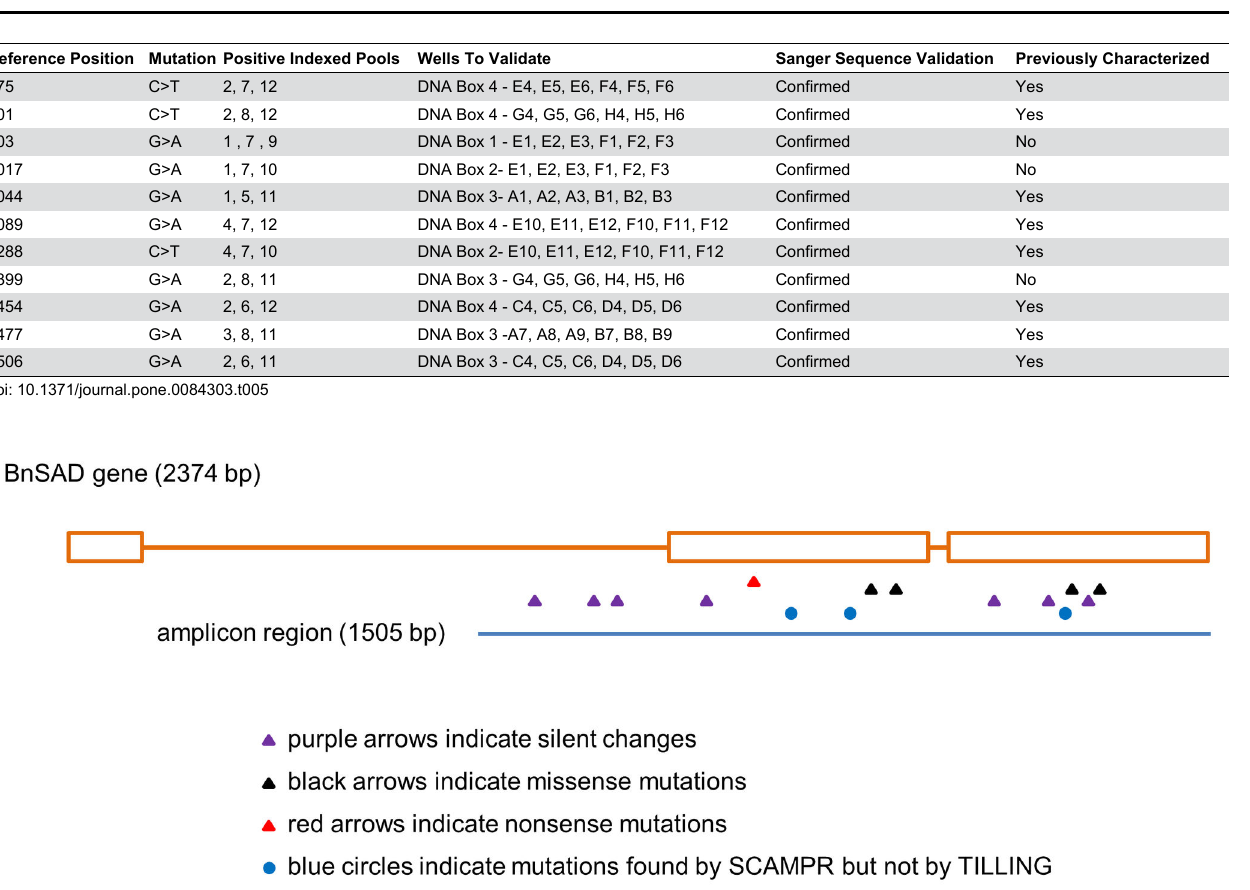
Table 5. Mutations identified by trial NGS sequencing (SCAMPRing) approach in 384 lines of the B. napus population.